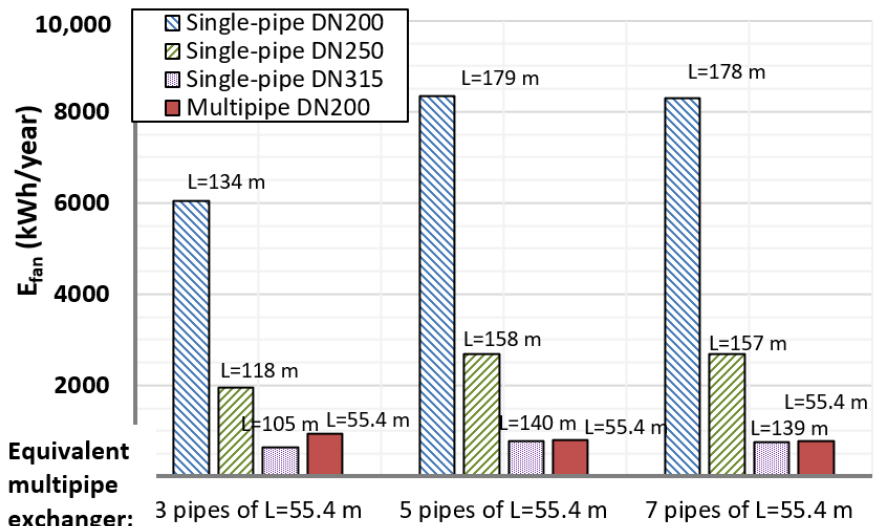
Figure 14. Full-year energy usage for driving the fans for multipipe structures of length L = 55.4 m and single-pipe structures of equivalent length in the context of heating capacity with different pipe diameters: d = DN200, DN250 or DN315, V = 1500 m 3 /h.